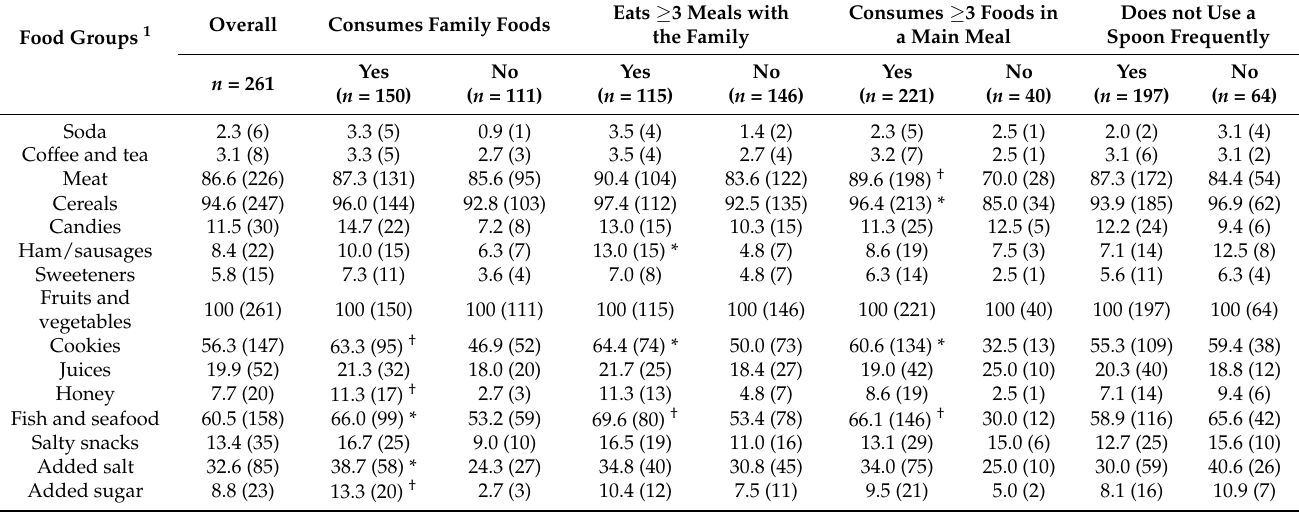
Table 3. Type of foods offered in the first 2 years by BLW component adherence.